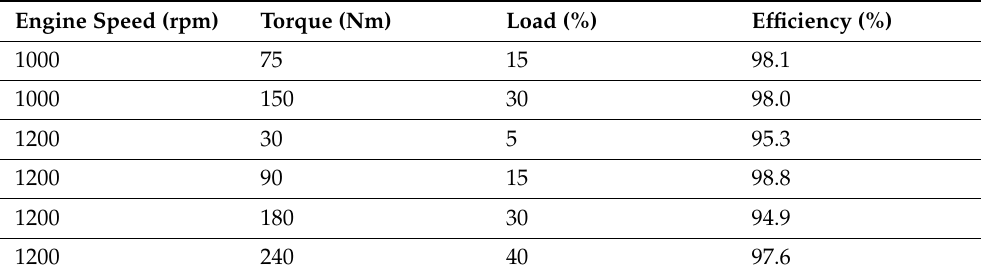
Table 8. Steady state engine points for CPF characterization and the abatement efficiencies